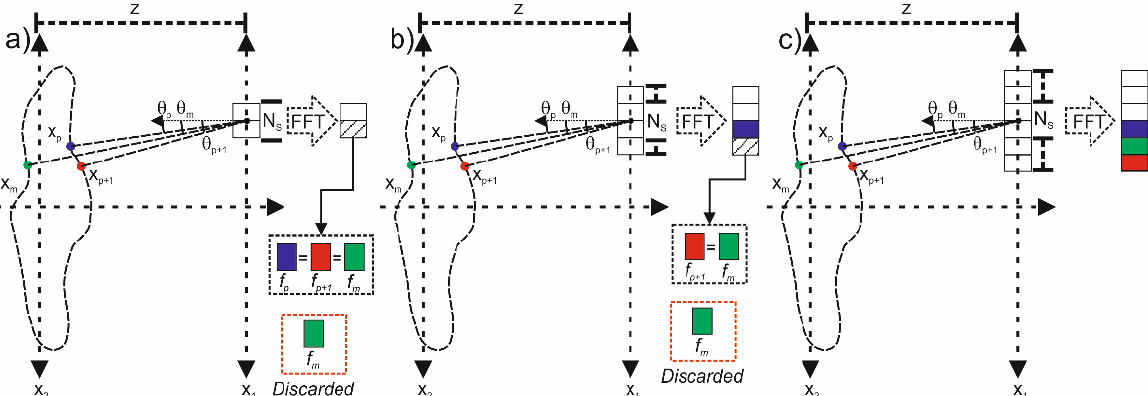
Figure 3. Allocation of discrete frequencies in the PAS algorithm: ( a ) small segment, ( b ) medium segment, and ( c ) large segment.